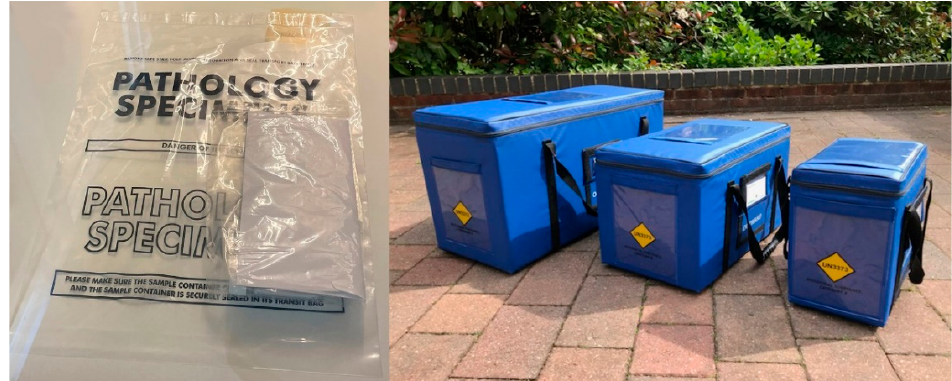
Figure 5. Pathology sample packaging (left) and insulated medical carriers (right). The medium-sized carrier is the middle of the three pictured. Approximately 125 pathology samples can be packed into a medium-sized carrier. Table 2. Capacities of PTS vehicles based at the Eastleigh depot.